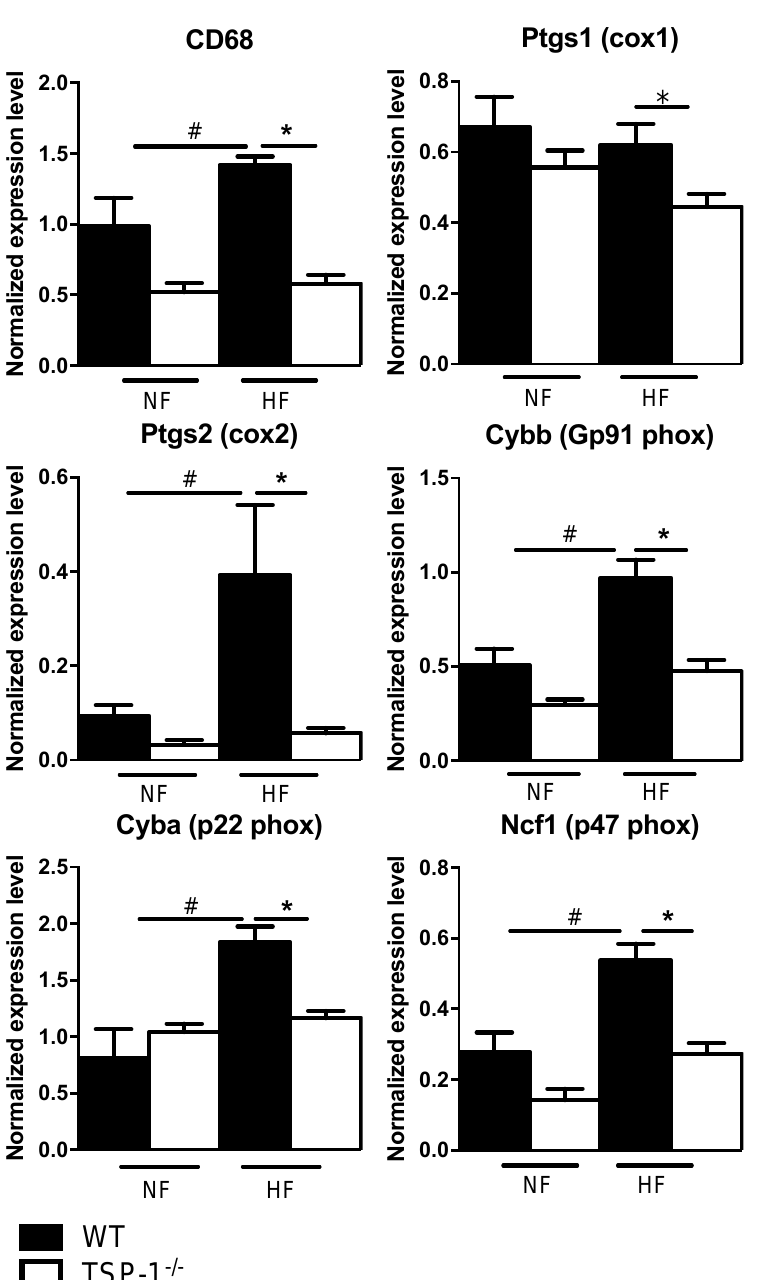
in TSP-1 − / − HF vessels, suggesting that TSP-1 may be involved in the flow-induced local inflammation.